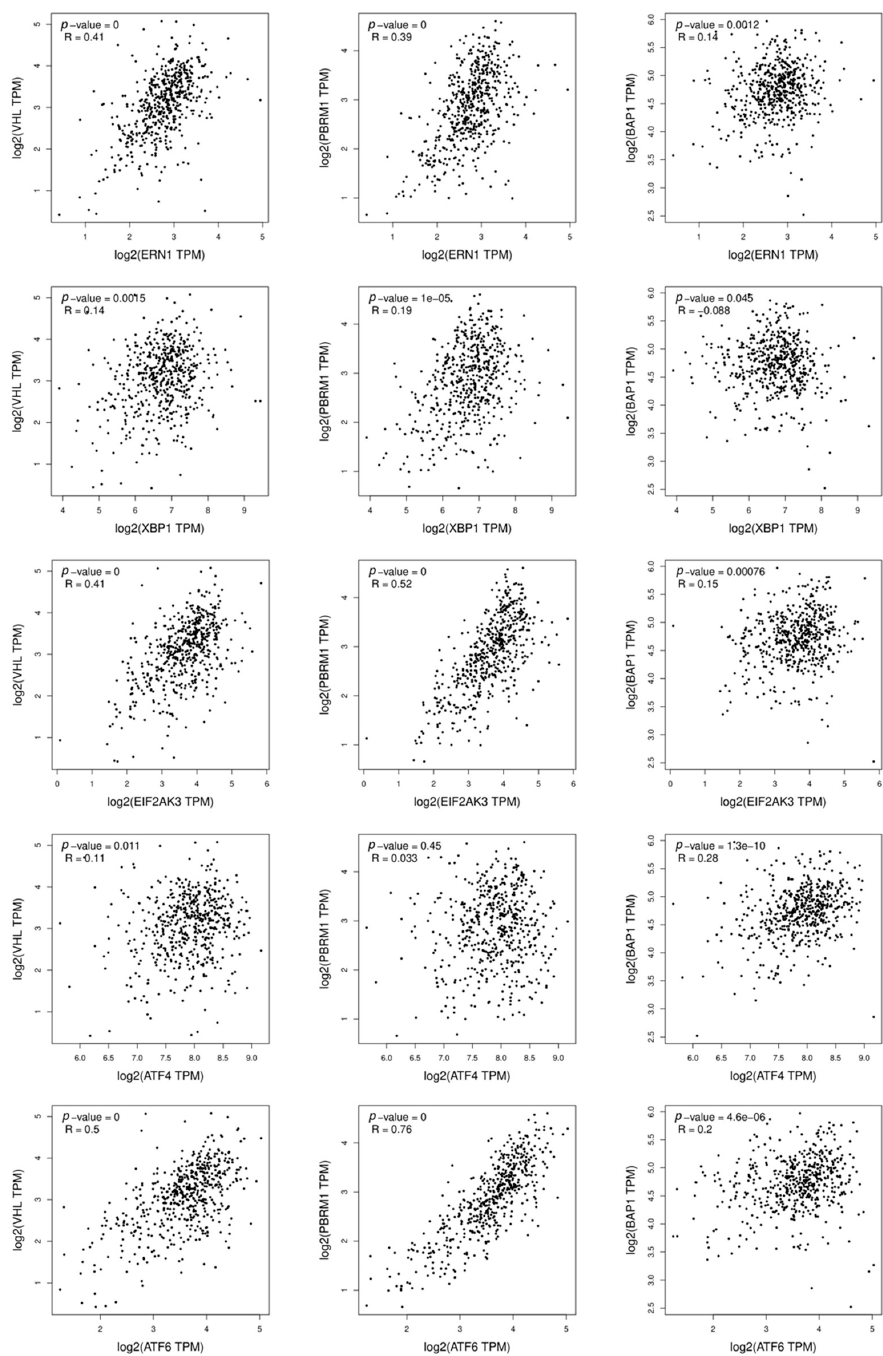
Figure 4. Correlation of ER stress markers and most commonly mutated genes in human ccRCC. Correlation of the expression of ER stress markers ( ERN1 (IRE1 α ), XBP1 , EIF2AK3 (PERK), ATF4 ,